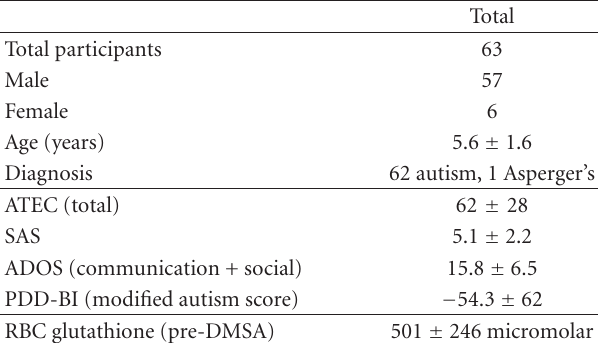
Table 1: Characteristics of participants. The second number is the standard deviation.